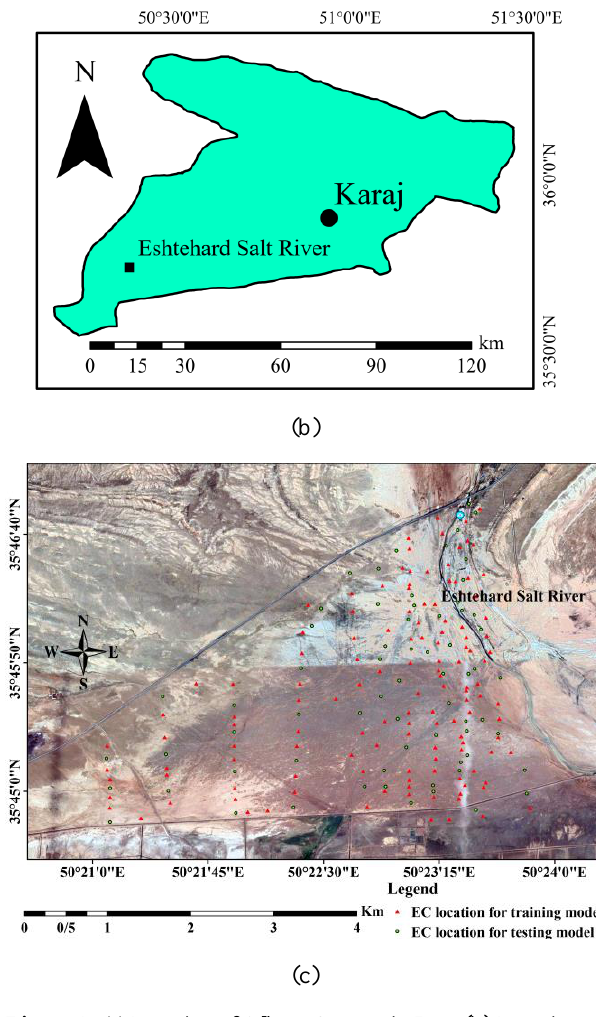
Figure 1. (a) Location of Alborz County in Iran, (b) Location of Eshtehard Salt River in the district of Alborz County, and (c) Eshtehard Salt River district image acquired from Google